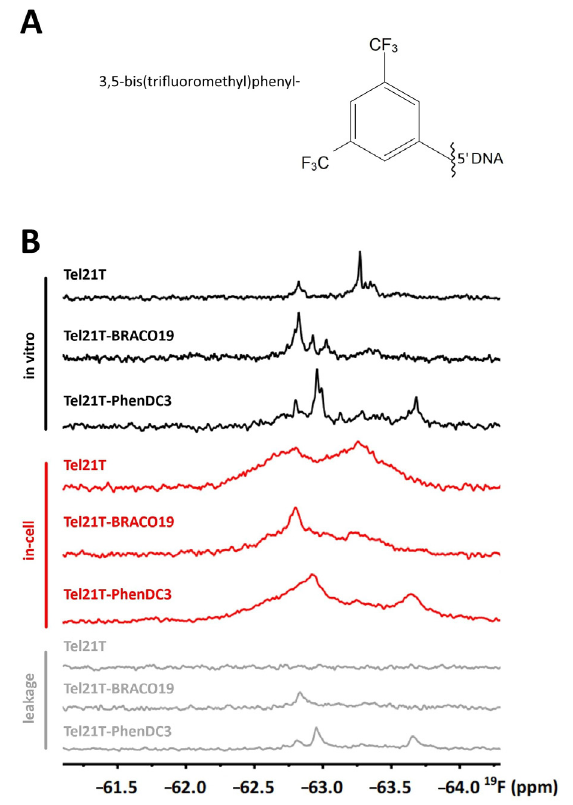
Figure 4. ( A ) The scheme of the 19 F-probe attached to the DNA—cf. [37]. ( B ) 1D 19 F NMR spectra of F-Tel21T, F-Tel21T–BRACO19, and F-Tel21T–PhenDC3 acquired in EC buffer (black line) and cells (red line). NMR spectra presented in gray correspond to the respective in-cell NMR leakage con-